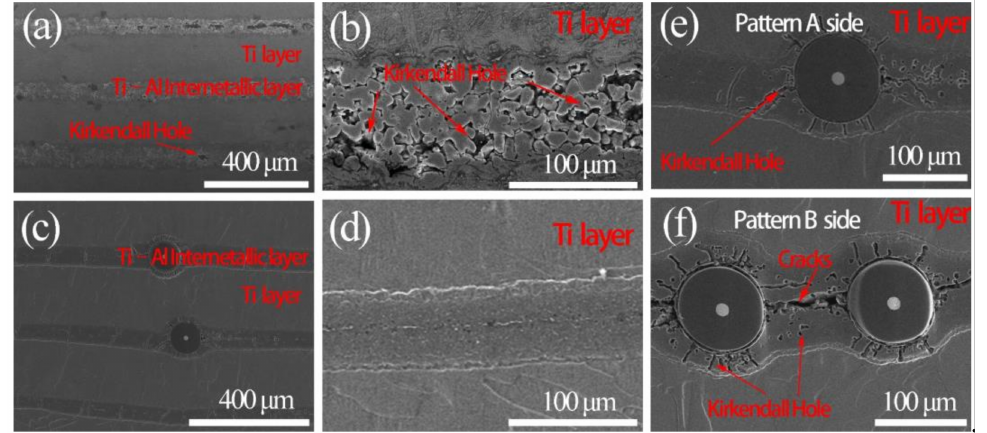
Figure 8. Microstructure of the fabricated laminated composites: ( a ), ( b ) Ti/Ti–Al laminated compos- ite; ( c – f ) SiC f -reinforced Ti/Ti–Al laminated